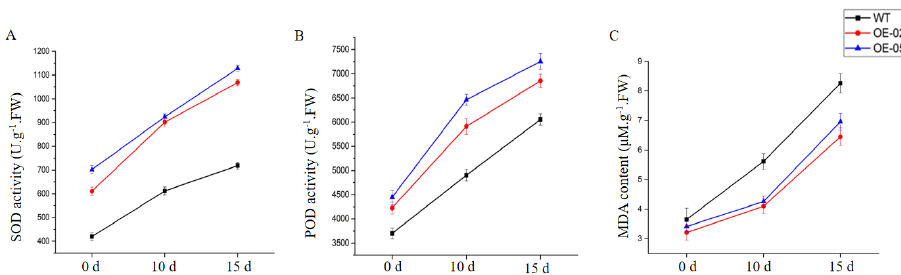
Figure 9. E ff ects of drought stress on superoxide dismutase (SOD) ( A ), peroxidase (POD) ( B ), and malondialdehyde (MDA) levels ( C ) in WT and transgenic plants after drought stress. The data represent three independent